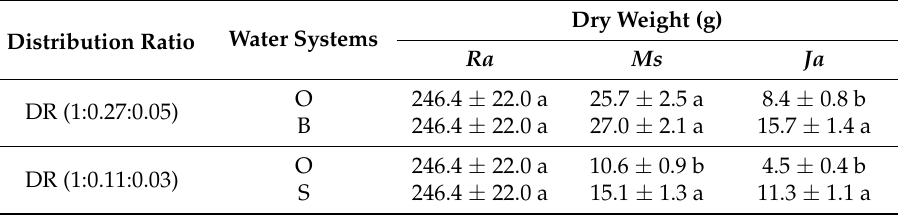
Table 3. Biomass itemized by species plants subjected to three water treatments used as criterion to assess their respective distribution ratio (DR, distribution ratio of the number plants of the three species that can be grown in each water system). O—open system, B—blended water system, and S—sequential reuse system. Data are the means ± standard deviation of four plants per treatment. Ra = Ruscus aculeatus , Ms = Maytenus senegalensis and Ja = Juncus acutus . Averages within a column with the same letters are not significantly different at p < 0.05 (ANOVA and LSD test).